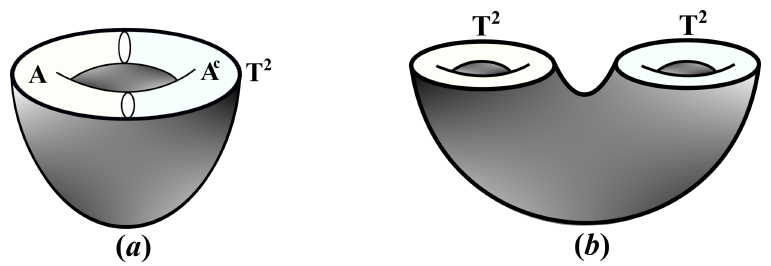
Figure 1. The two approaches to study the topological entanglement: the manifold in ( a ) has a single torus boundary, which is bi-partitioned into spatially connected regions A and A c . The manifold in ( b ) has two disjoint torus